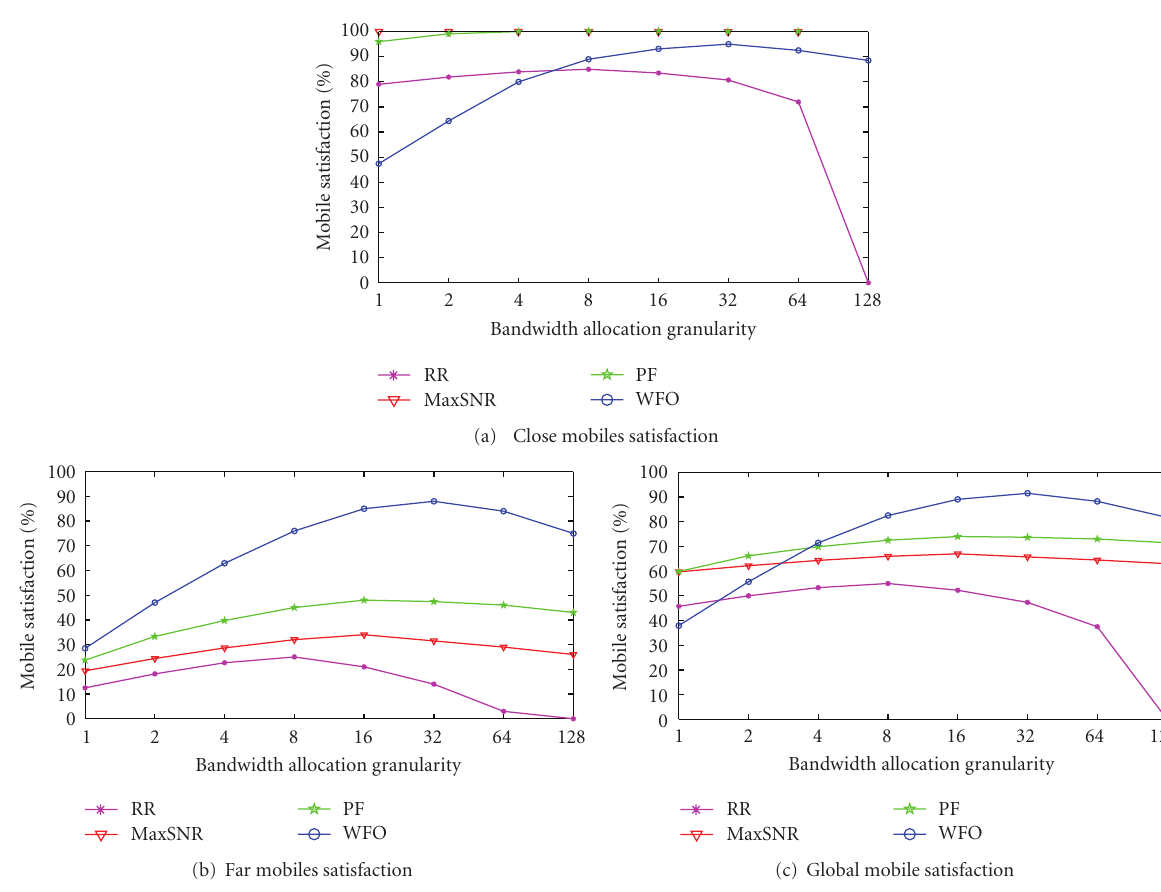
Figure 8: Analysis of the mobile